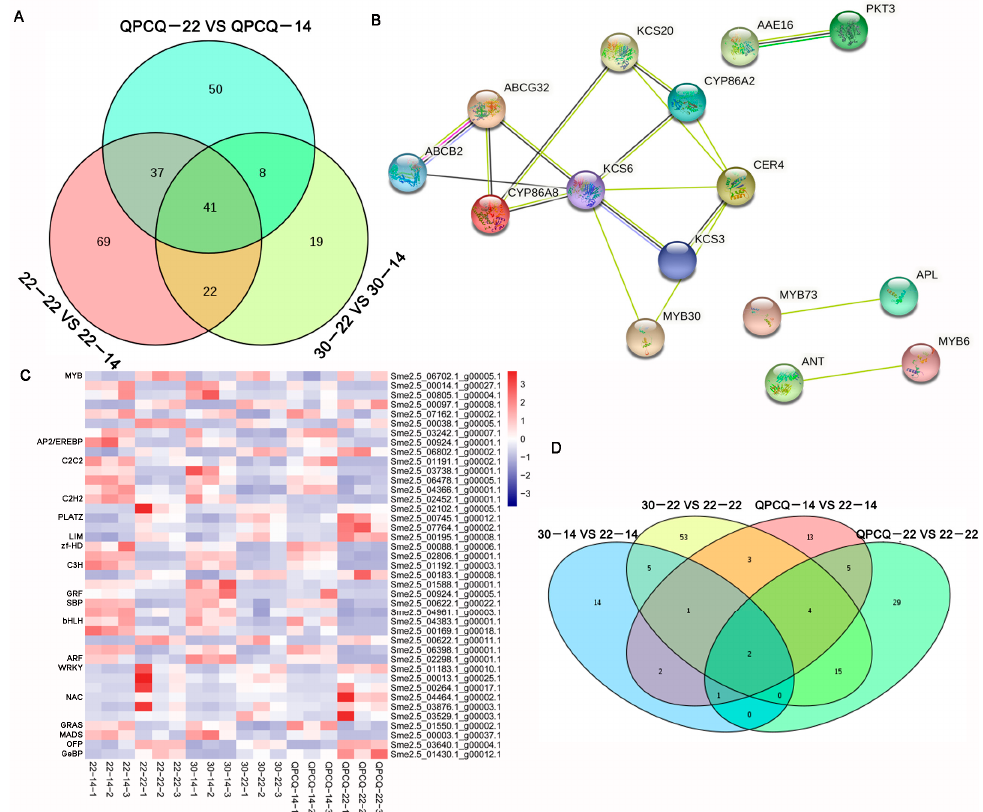
Figure 7. Differentially expressed genes (DEGs) identified as transcription factors (TFs) in eggplants of different brightness. ( A ) Venn plot of groups 22-22 vs. 22-14, 30-22 vs. 30-14, and QPCQ-22 vs. QPCQ-14. ( B ) Interaction net among TFs and cuticle-related genes at different eggplant development stages. ( C ) Heat map of 41 TFs at different eggplant development stages. ( D ) Venn plot of groups 30-14 vs. 22-14, 30-22 vs. 22-22, QPCQ-14 vs. 22-14, and QPCQ-22 vs. 22-22.